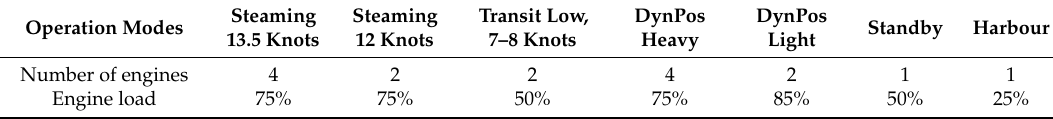
Table 4. Number of operating engines and engine load for different operation modes. 150